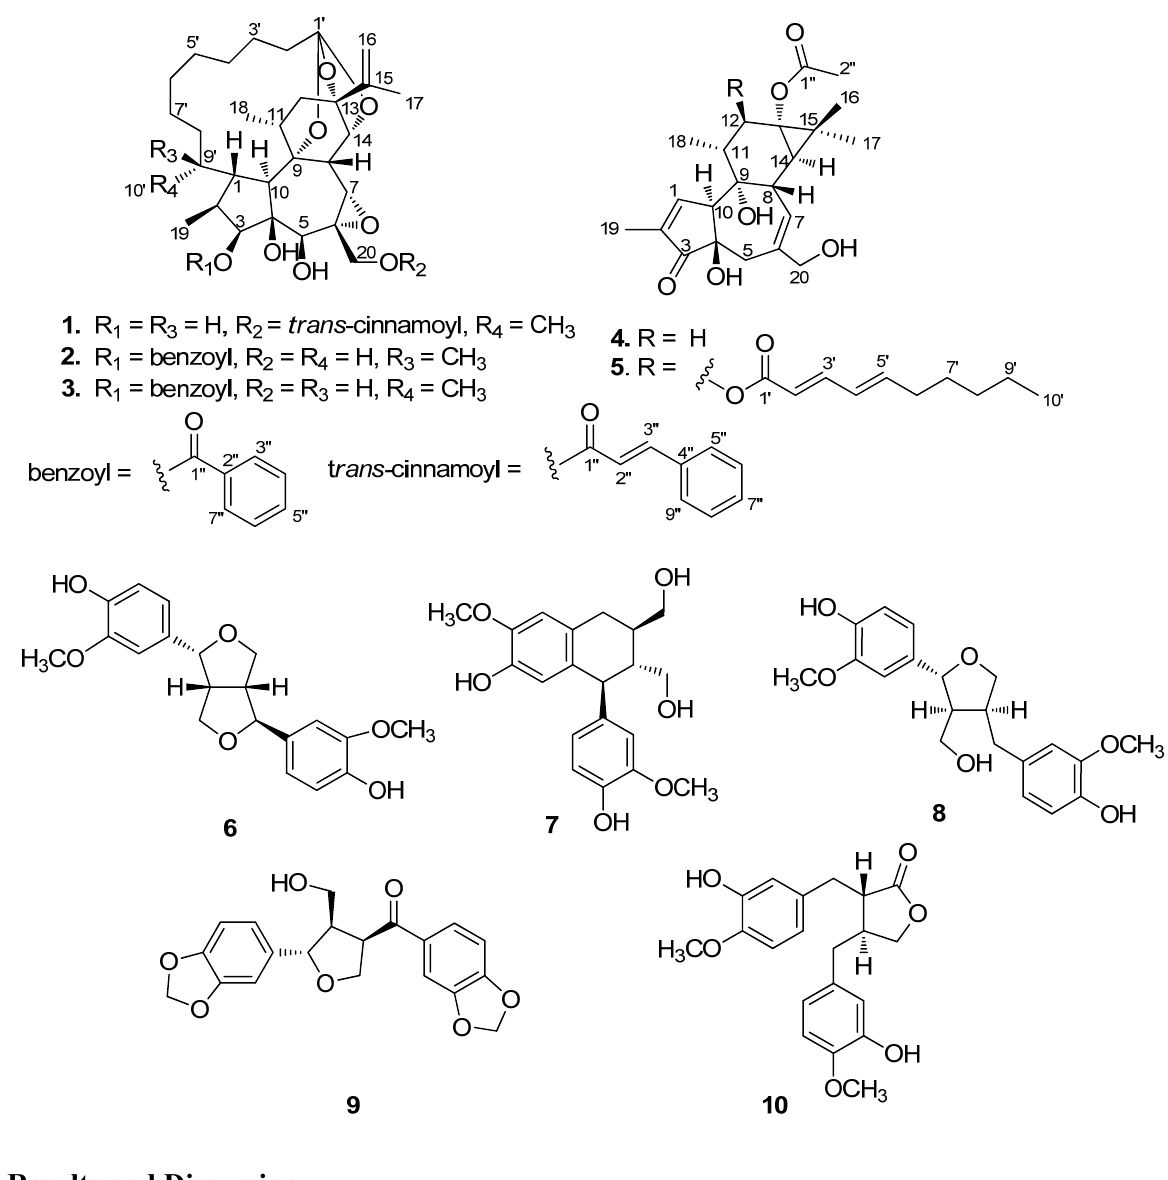
Figure 1. Structures of compounds 1 – 10